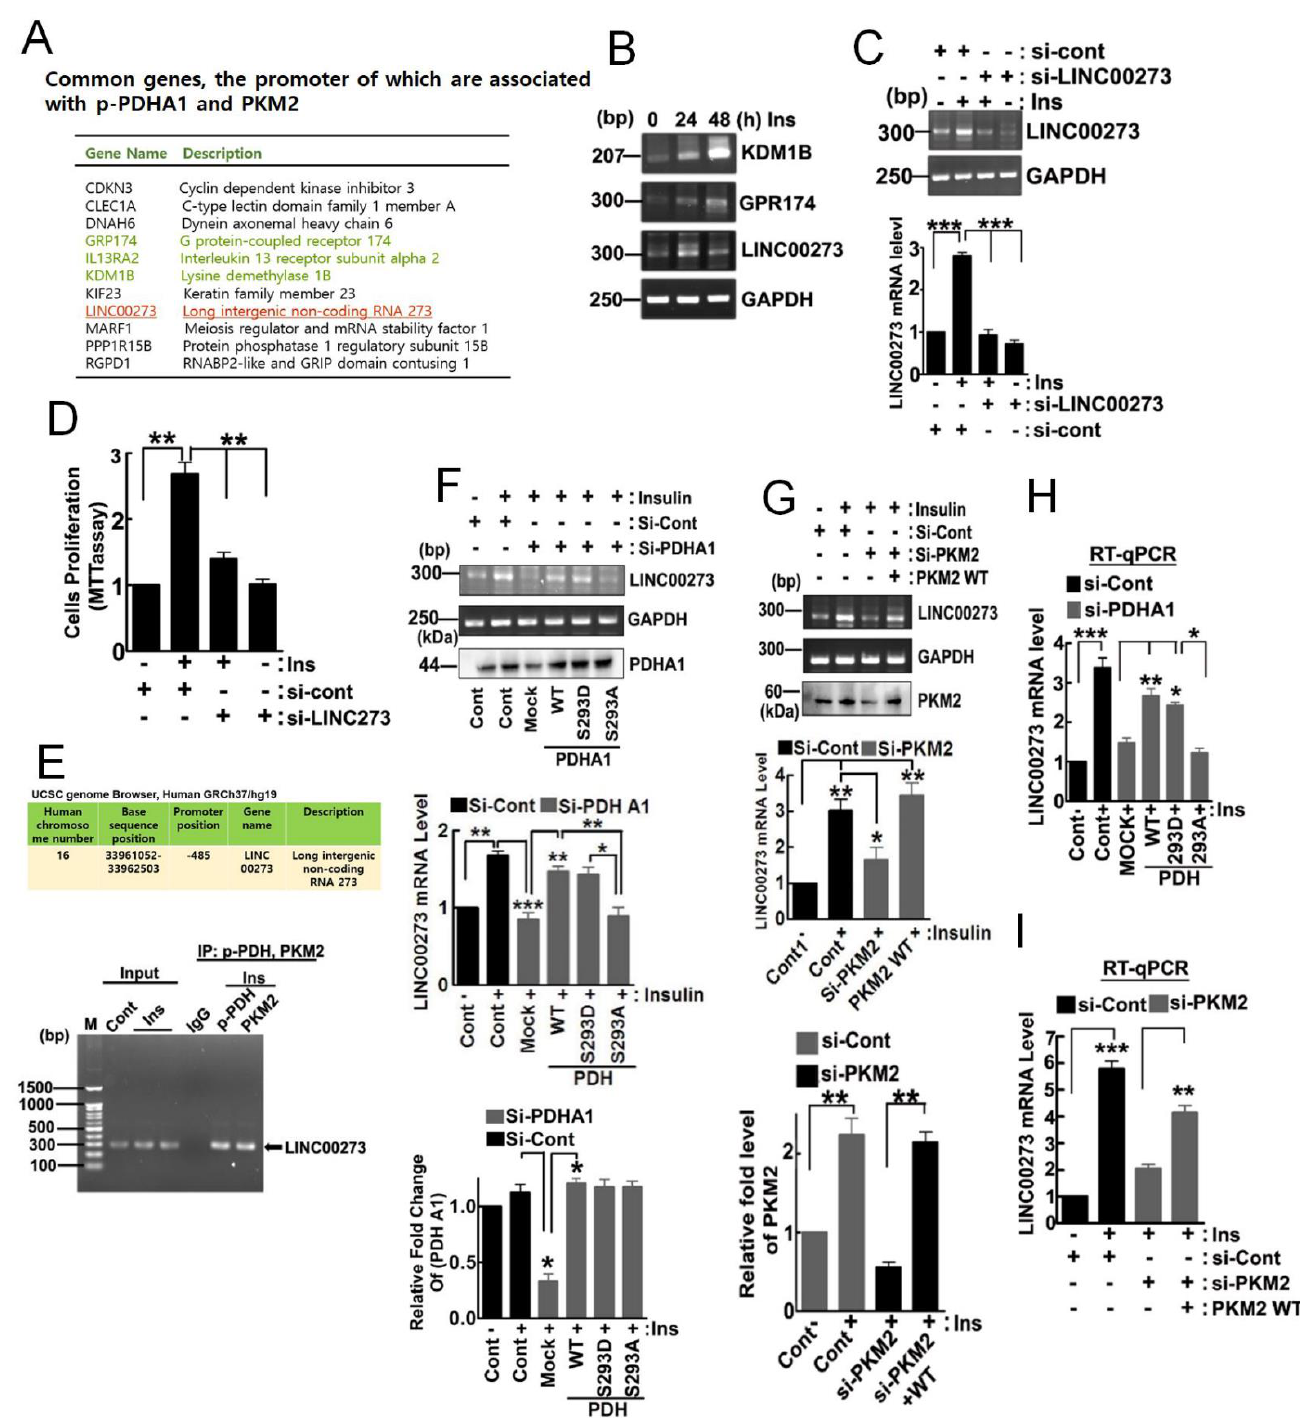
Figure 3. p − PDHA1 binds to the promoter of specific genes and regulates their expression. ( A ) Promoters of genes that were associated with p-PDHA1 and PKM2 were identified by ChIP sequencing. ( B ) HepG2 cells were treated with insulin (100 nM in indicated time) and mRNA levels of KDM1B, GPR174, and LINC00273 were determined by RT-PCR. ( C ) HepG2 cells were transfected with si-control and si-LINC00273 and then stimulated by 100 nM insulin for 24 h. Then, silencing of LINC00273 mRNA level measured by RT-PCR. ( D ) HepG2 cells were transfected with si-LINC00273 and stimulated with or without 100 nM insulin for 24 h. Then cell proliferation was measured by the MTT assay. ( E ) ChIP-PCR was conducted with primers of LINC00273 from the HepG2 cells stimulated with insulin (100 nM for 48 h). ( F ) HepG2 cells were transfected with si-PDHA1 with the addback PDHA1 WT, S293D, and S293A mutants with Insulin (100 nM for 24 h) and LINC00273